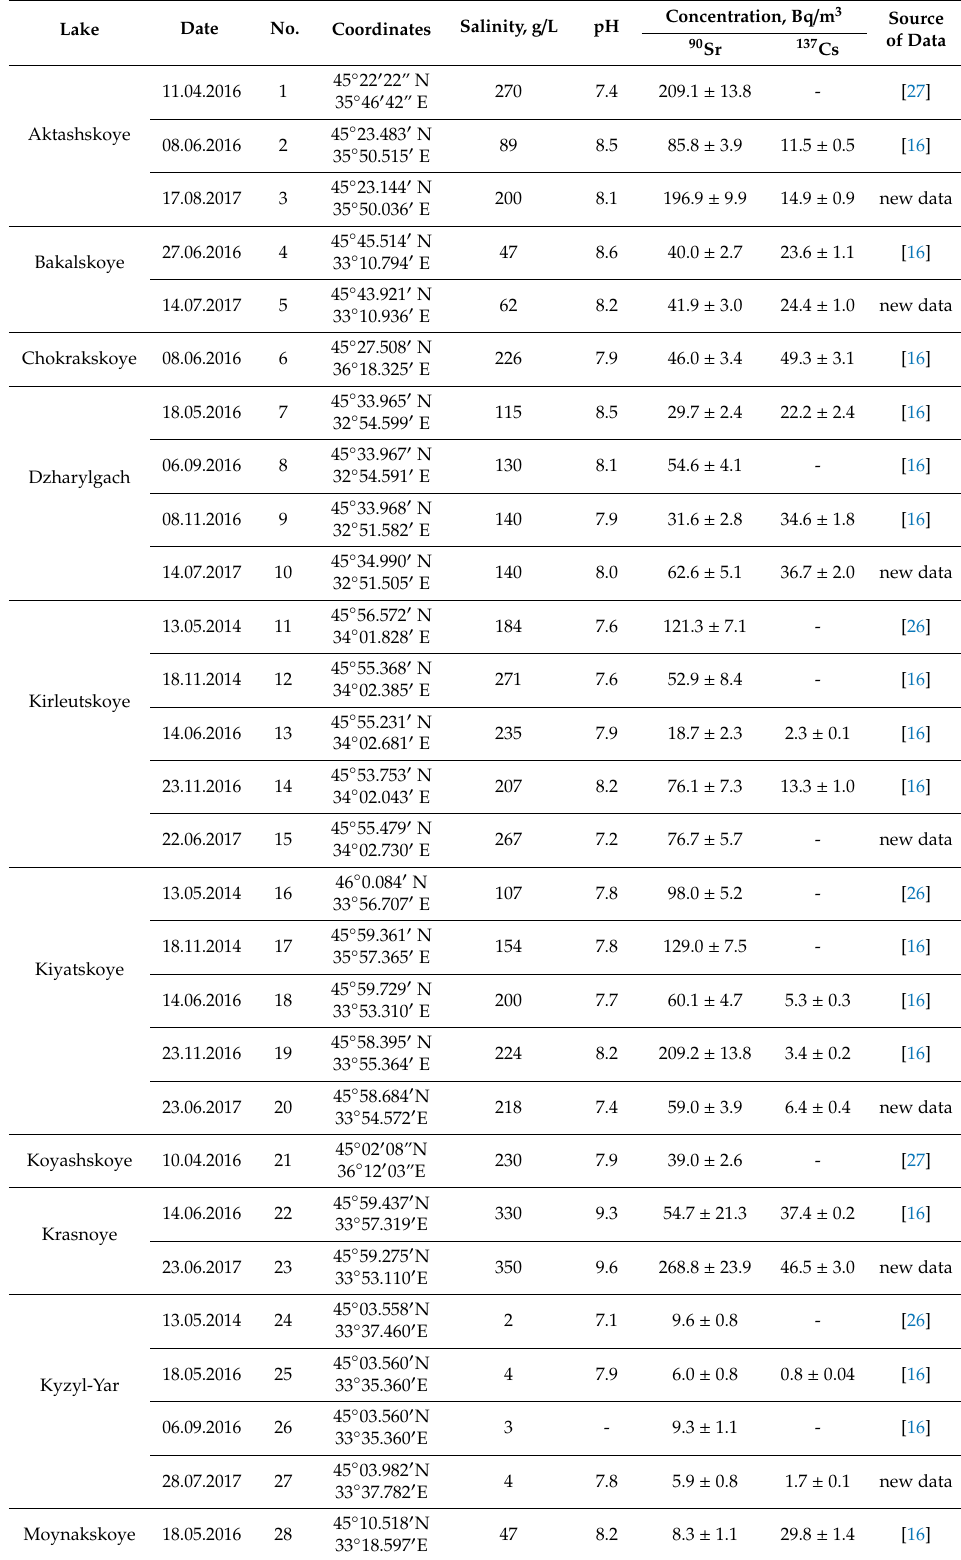
Table 1. Measured concentrations of 90 Sr and 137 Cs in water of the Crimean saline lakes during